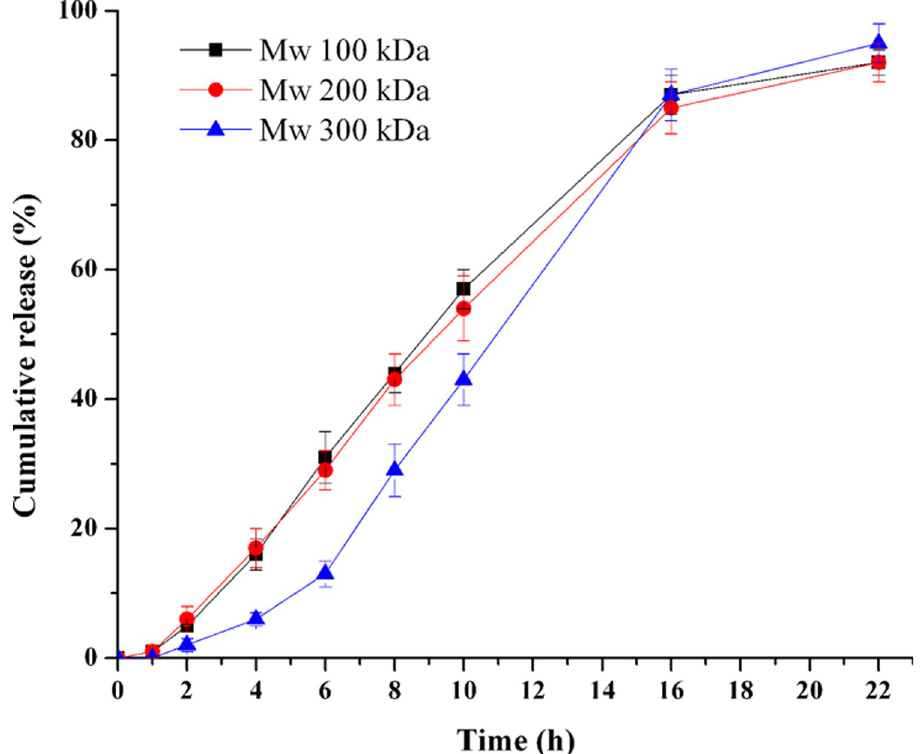
Fig 2. Effect of PEO molecular weight in drug layer on the TPM release (n =